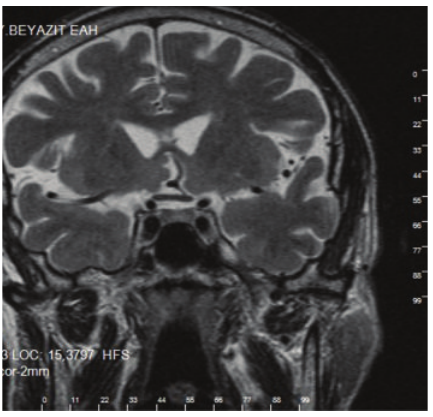
Figure 2: T2-weighted MRI demonstrated that 5 × 8mm mass the has irregular borderline.